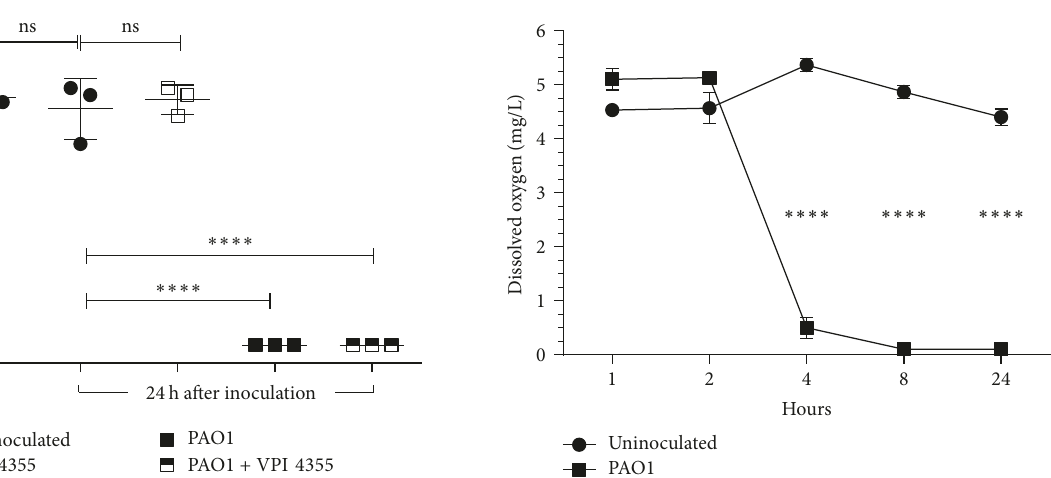
Figure 6: Growth of P. aeruginosa creates anaerobic conditions within 4 h of inoculation. Fifty mL tubes of BHI broth were left uninoculated or inoculated with 10 6 CFU PAO1 and incubated for 24 h at 37 ∘ C. Levels of DO 2 were measured at times indicated. Values represent the means of three independent experiments ± SEM; ∗∗∗∗ 𝑃 < 0.0001